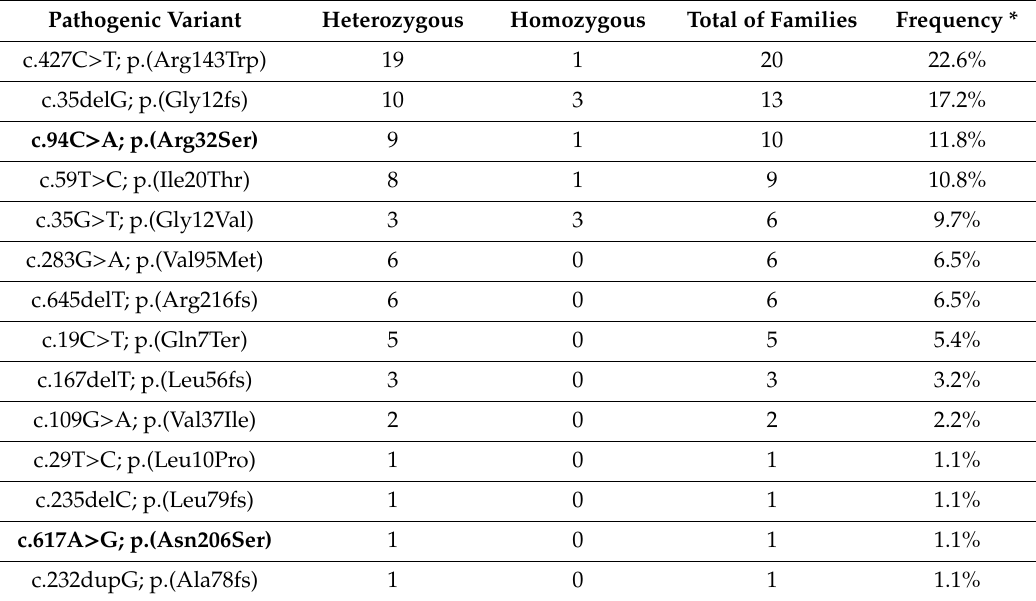
Table 1. Pathogenic variants identified in